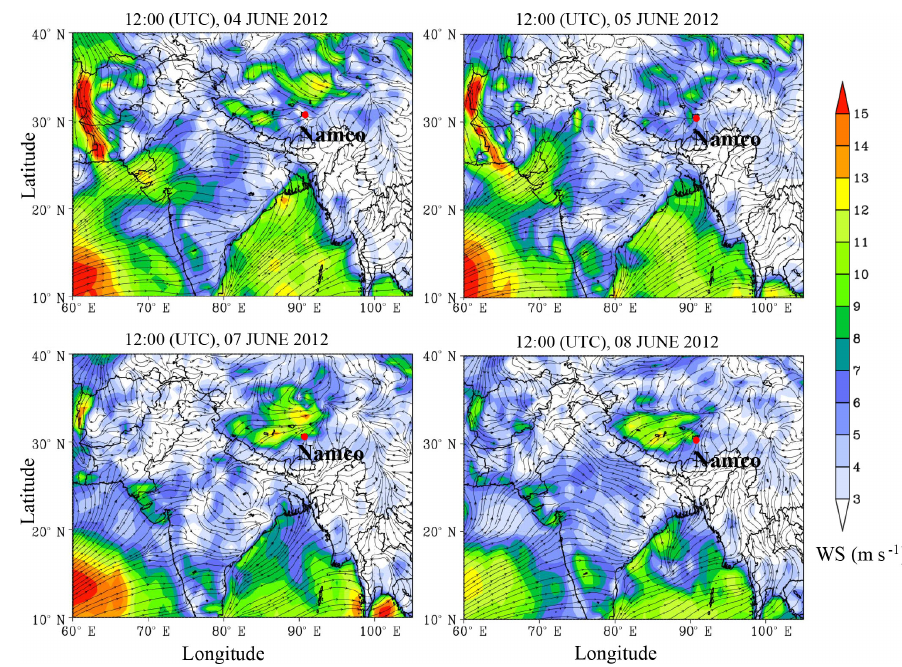
Figure 11. Average fields of wind at sigma = 0.995 for 12:00 (UTC) for 4, 5, 7, and 8 June 2012.